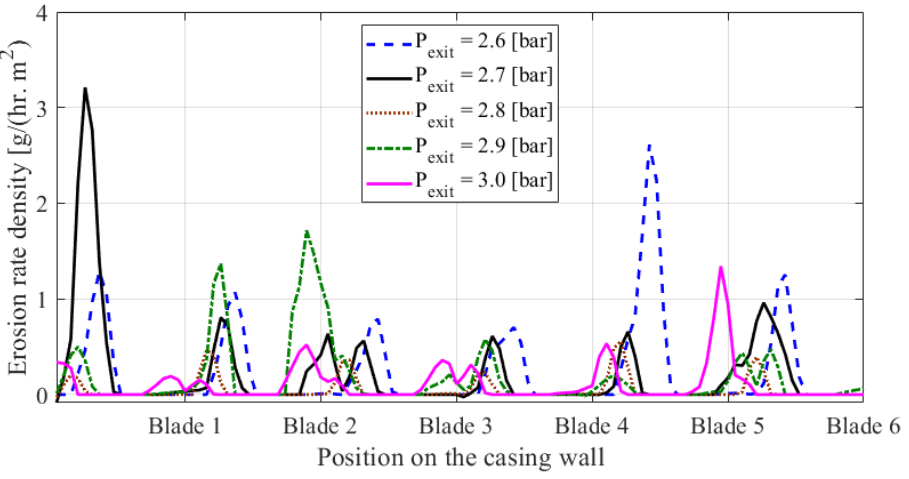
Figure 20. Variation of concentration of particles along the casing wall with different values of exit pressure heads.